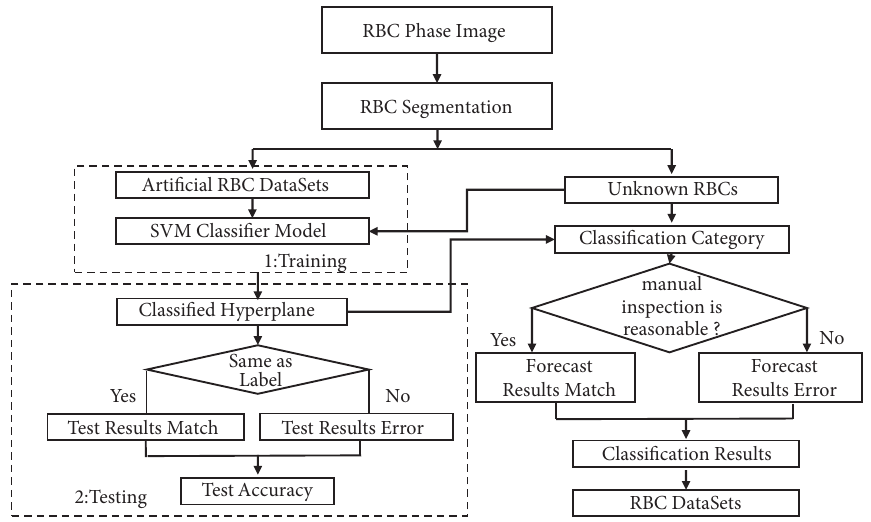
Figure 3: Flowchart of RBC dataset preparation based on